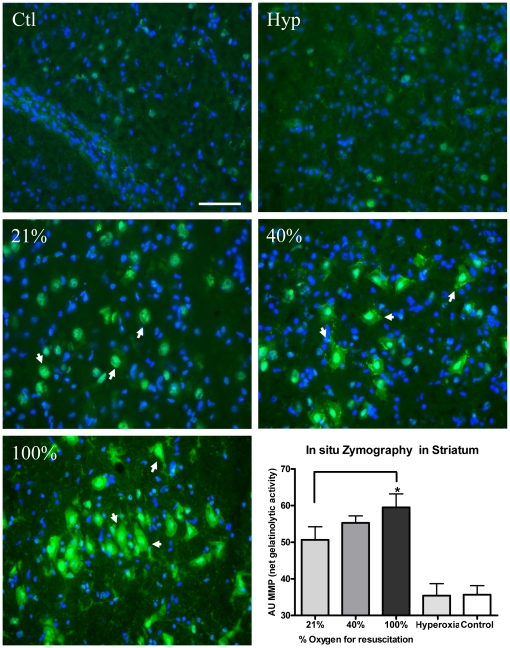

In situ zymography in the corpus striatum.Net gelatinolytic activity increases in the striatum after hypoxia-resuscitation. Fluorescence photomicrographs of striatum sections showing in situ zymography in sham operated (Ctl) and hyperoxia (Hyp) controls and after reoxygenation with 21%, 40% or 100% O2. Overall, fluorescence signal representing proteolytic activity (green) increases after hypoxia-resuscitation in the entire tissue, but the most prominent changes occur in discrete neuronal populations (arrows) in a dose-response manner. Hoechst stain was used as a nuclear marker (blue). Scale bar: 150 µm. The graph represents the quantification of net gelatinolytic activity (in arbitrary units (AU) of fluorescence) for 21% (n = 8) 50.64 (10.1), 40% (n = 8) 55.29 (5.4), 100% (n = 9) 59.51 (11.1), hyperoxia (n = 6) 35.42 (8.0) and controls (n = 6) 35.67 (6.1). There was a significant increase in net gelatinolytic activity in the corpus striatum in all groups exposed to hypoxia-reoxygenation vs the control group (p = 0.024, p = 0.002 and p<0.001 for the 21%, 40% and 100% group). The hyperoxia-group was similar to the control group. Using post hoc multiple comparisons between group means (Fisher LSD), we found a significant increase in the 100% oxygen group compared to the 21% oxygen group (p = 0.043). Values are expressed as a mean (±SD), *p<0.05, **p<0.01.